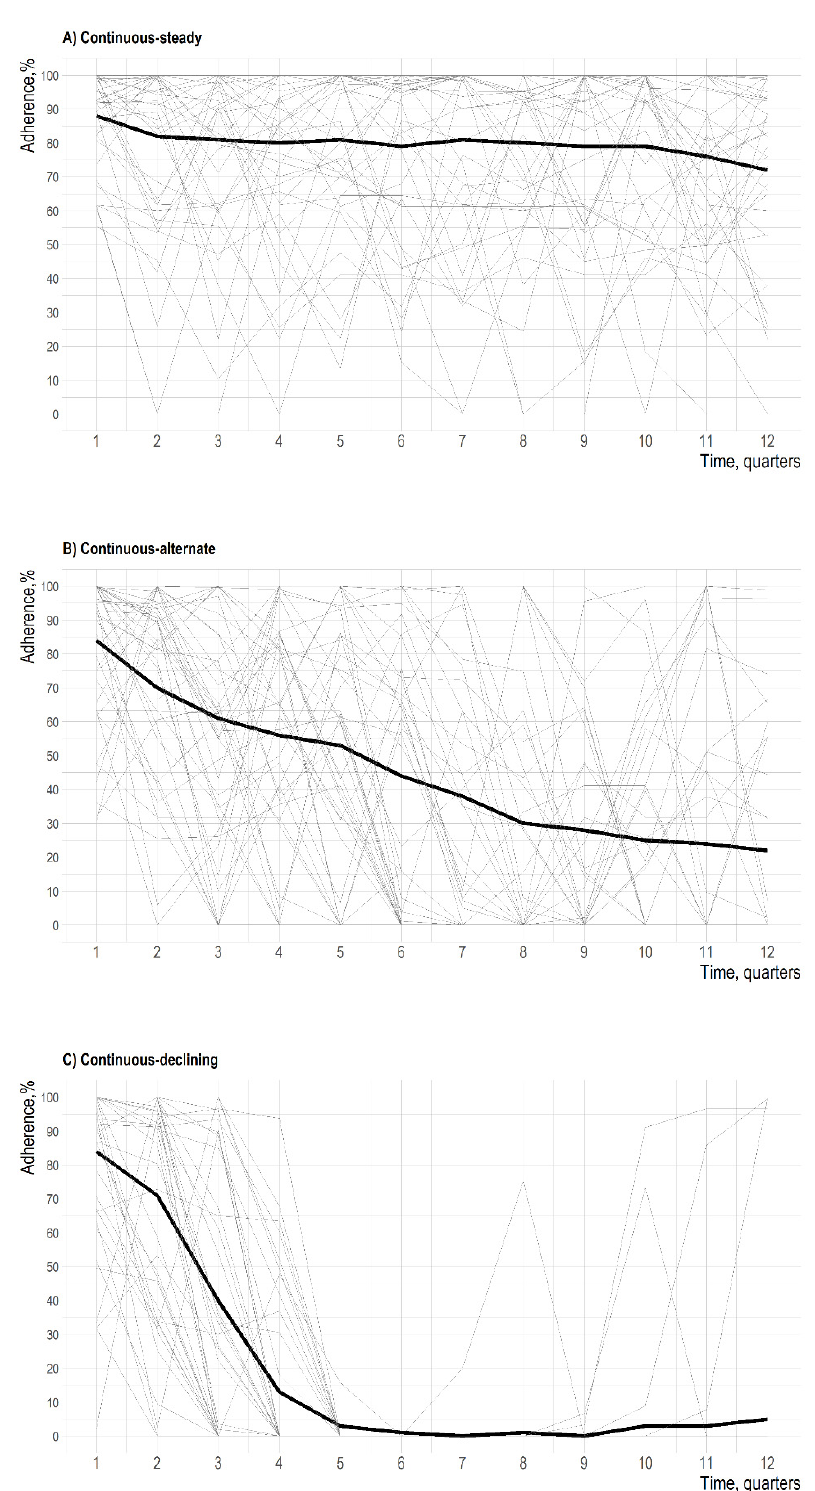
Figure 5. Spaghetti plot of random samples of 50 patients selected from each of the 3 adherence sub-trajectories identified in the second-phase analysis. Individual and mean sub-trajectories are displayed in grey and black, respectively.